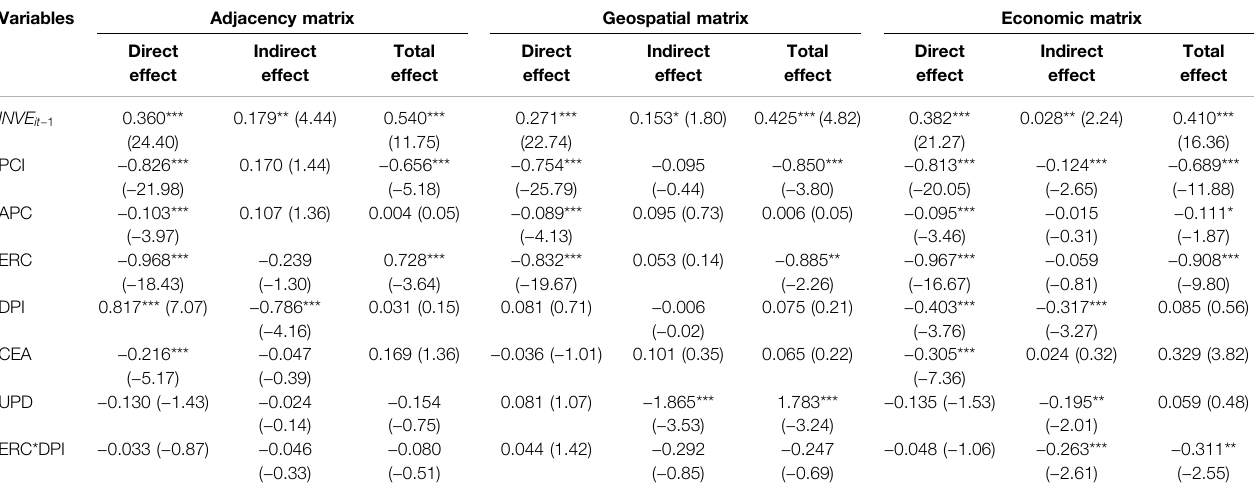
TABLE 9 | Decomposition of the random effects SDM (INVE5).